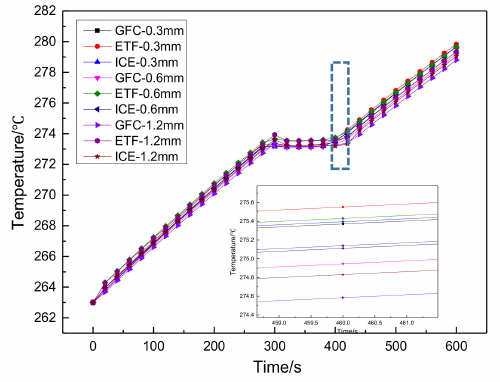
Figure 22. Average temperature of each layer of ETF with di ff erent pore